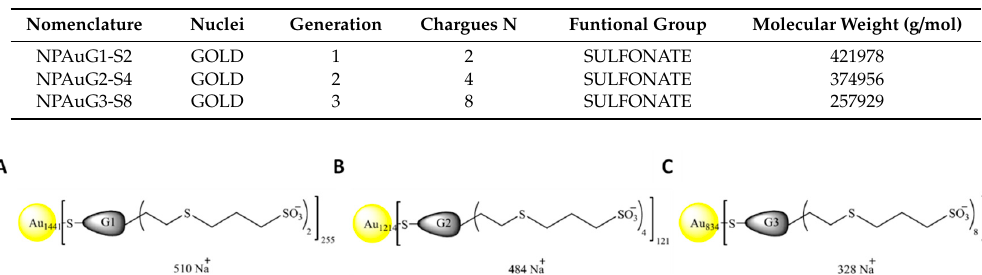
Table 1. Characteristics of the selected NPAuG1-S2, NPAuG2-S4, and NPAuG3-S8.